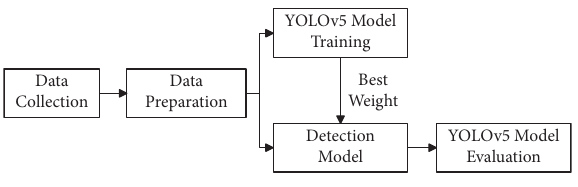
Figure 1: Object detection process.